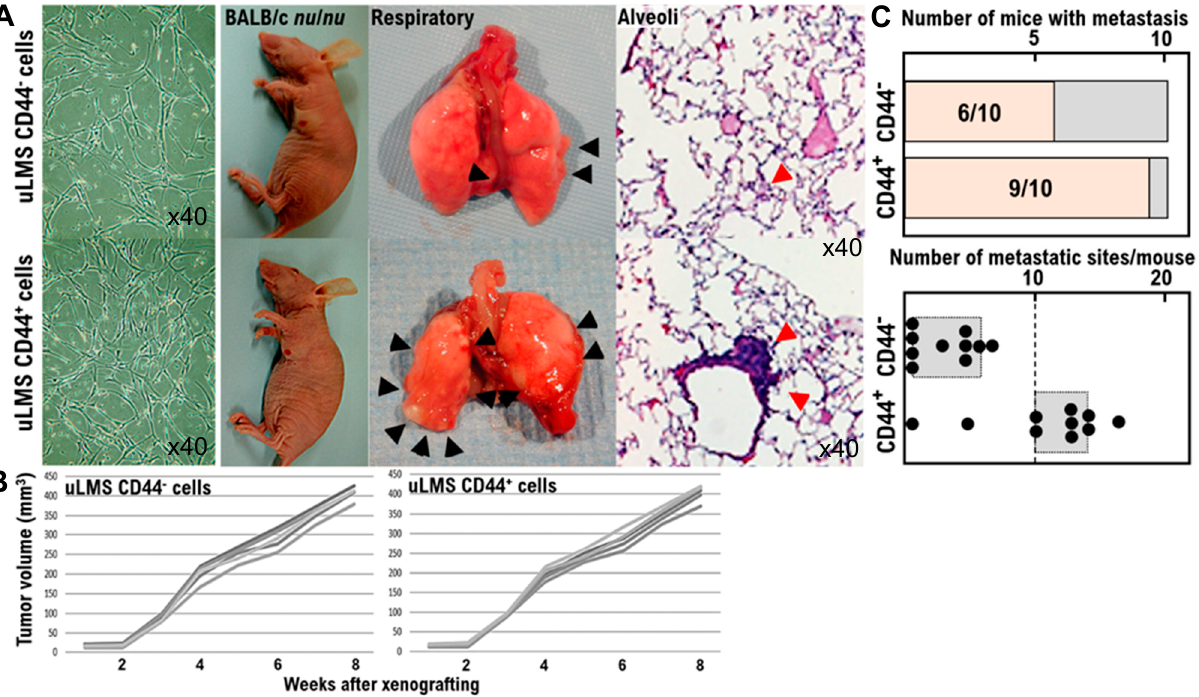
Figure 2. Induction of micrometastases in alveolar tissues derived from BALB/c nu/nu mice xenografted with human CD44-positive SK-LMS-1 stem-like cells. ( A ) Photographs show xenografts derived from BALB/c nu/nu mice inoculated with CD44-negative SK-LMS-1 cells or CD44-positive SK-LMS-1 cells at 2 months after the injection. Xenografts derived from BALB/c nu/nu mice inoculated with CD44-positive SK-LMS-1 cells were highly angiogenic. Data are representative of one of ten independent experiments obtained with different xenograft samples derived from CD44-negative SK-LMS-1 cells or CD44-positive SK-LMS-1 cells. The photographs show the pathology in metastasizes of respiratory tissue derived from the primary tumor on the left side of the second mammary fat pad, and micrometastases in the alveolar tissues of BALB/c nu/nu mice xenografted with CD44-negative SK-LMS-1 cells or CD44-positive SK-LMS-1 cells at 2 months after injection. In xenograft experiments using BALB/c nu/nu mice, the tumorigenicity of CD44-negative SK-LMS-1 cell and CD44-positive SK-LMS-1 cell xenografts was similar. Data are representative of one of ten independent experiments obtained with different xenograft samples derived from CD44-negative SK-LMS-1 cells or CD44-positive SK-LMS-1 cells. Metastatic tissues are indicated by black arrows.